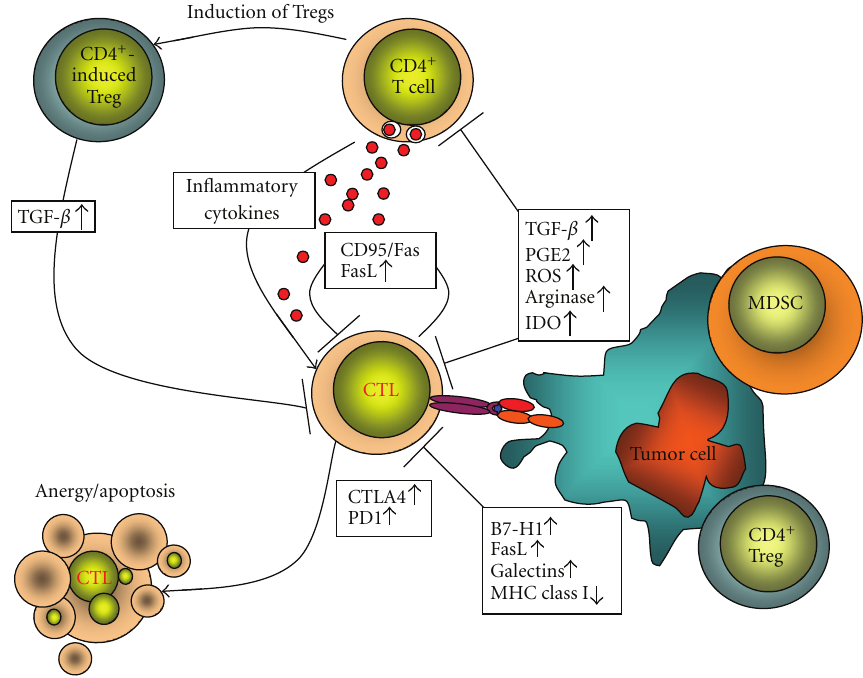
Figure 2: Overview of immunosuppressive evasion mechanisms. Tumor cells and tumor-infiltrating Tregs and MDSC can employ a plethora of immunosupressive factors and molecules that impair T-cell function or lead to T-cell anergy and/or apoptosis. Depicted are immunosuppressive self-inhibitory circuits of activated CTLs and also immunosuppressive mechanisms of